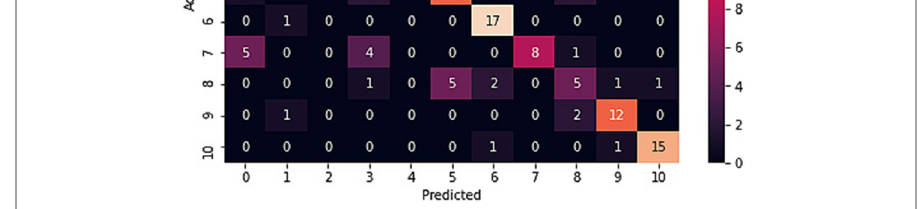
Fig. 5 The confusion matrix based on “Sastrawi”